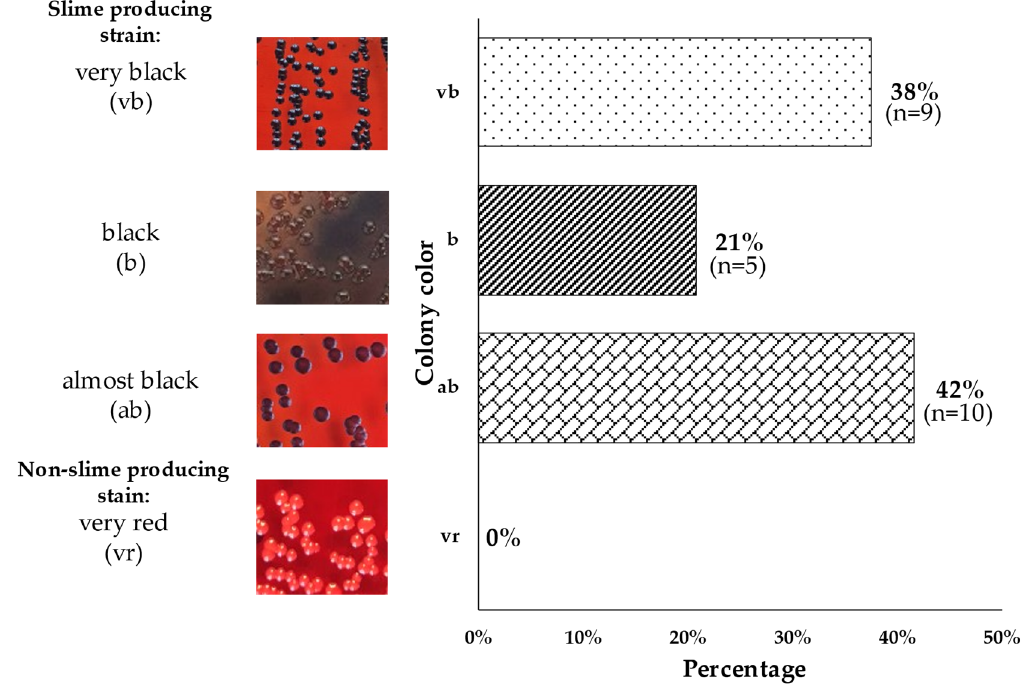
Figure 4. Mucus production results for S. aureus isolated from tracheostomy tubes using the CRA method. Legend: vb— S. epidermidis ATCC ® 35984™ (positive control); b—isolate TT_28 (1); ab—isolate TT_17; vr— S. epidermidis reference strain ATCC ® 12228™ (negative control).